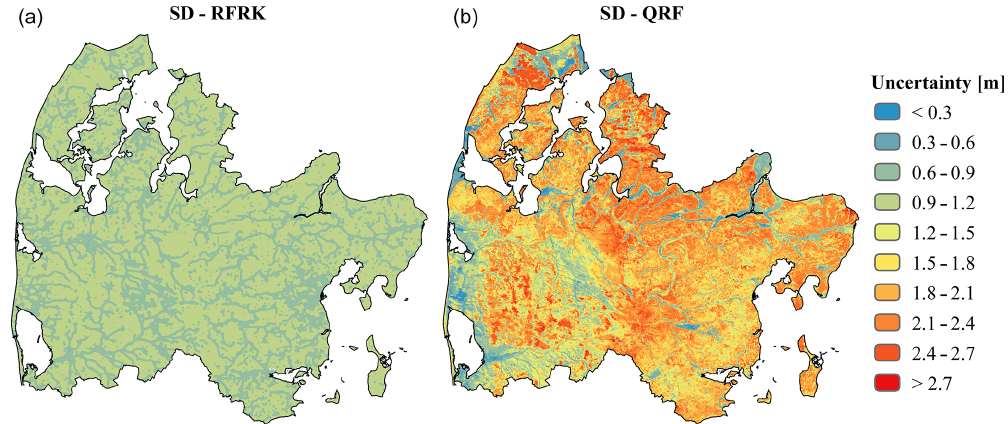
Figure 8. Two methods to quantify the uncertainty of a RF model are implemented: RFRK (a) and QRF (b) . For all maps, uncertainty is expressed as the standard deviation